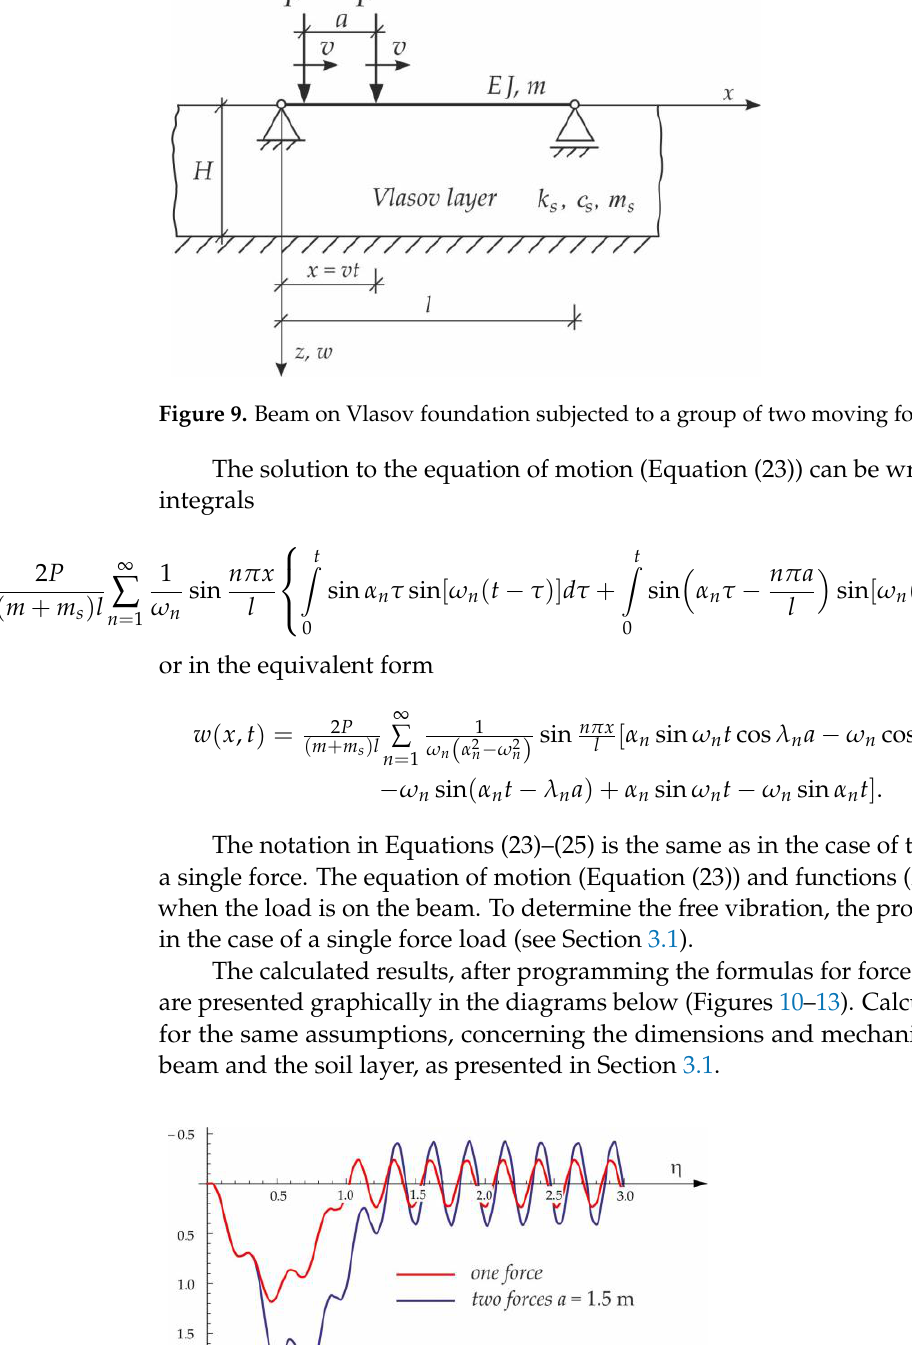
Figure 9. Beam on Vlasov foundation subjected to a group of two moving forces.